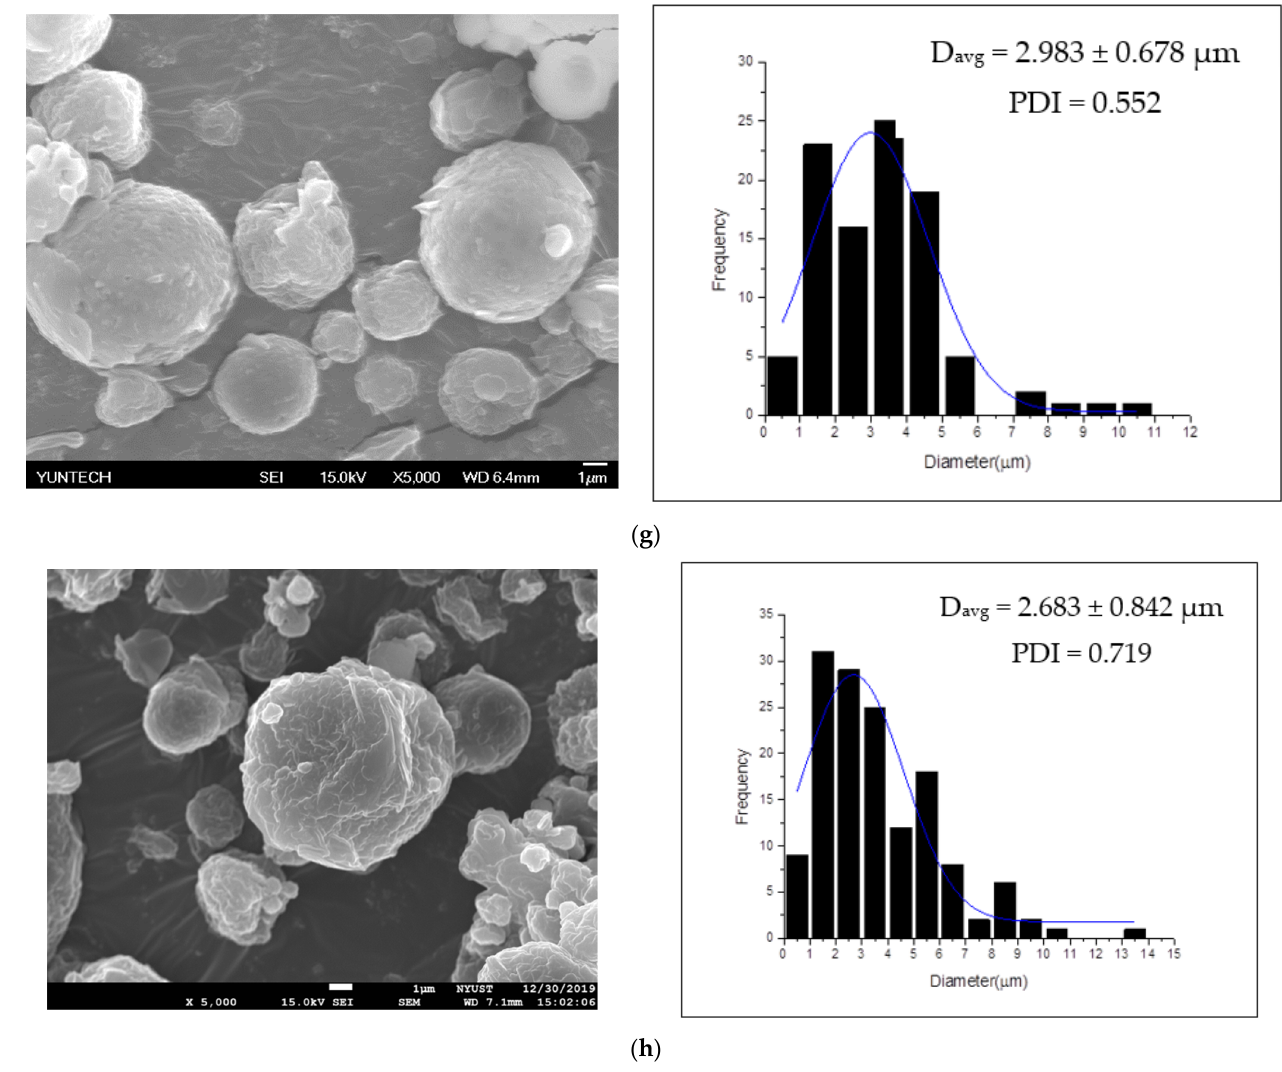
Figure 4. Morphology of ( a ) curcumin ( b ) extract of jelly fig at 1000×, ( c ) Morphology and particle size distributions of C-0.75JFMs 80 °C, ( d ) C-1.5FJMs 80 °C, ( e ) C-2.25JFMs 80 °C, ( f ) C-0.75JFMs 90 °C, ( g ) C-1.5FJMs 90 °C, and ( h ) C-2.25JFMs 90 °C.